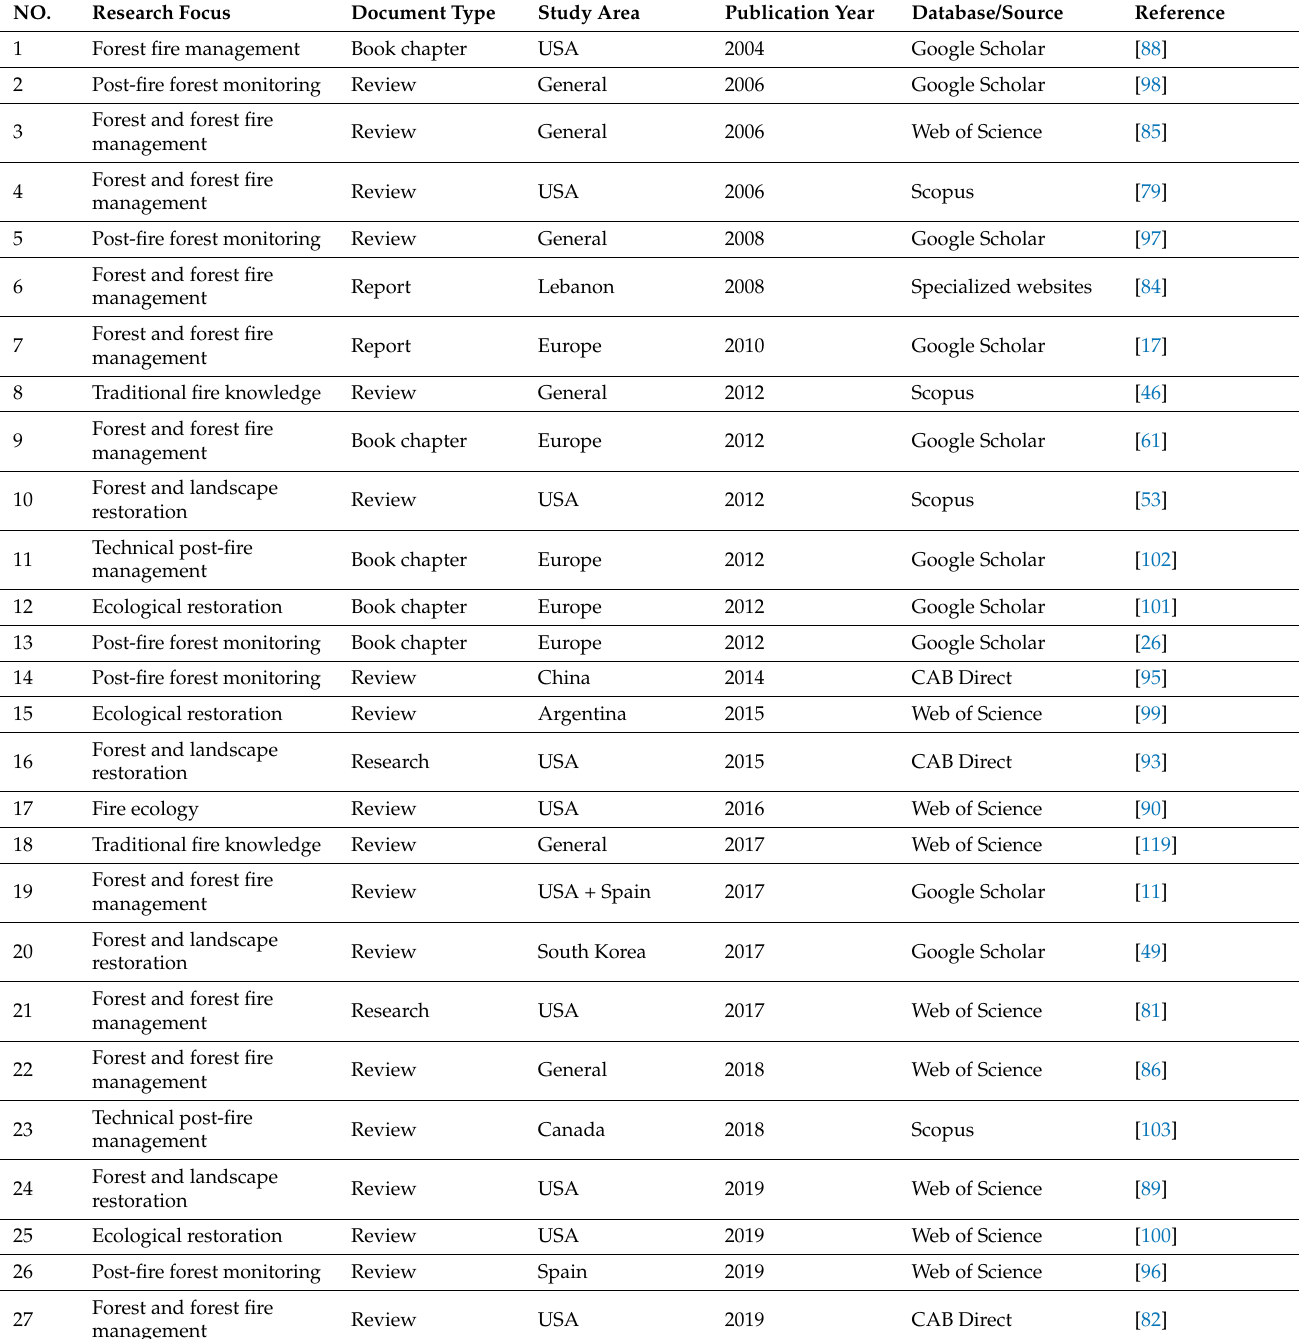
Table A1. Details of the articles selected for this review ( n =